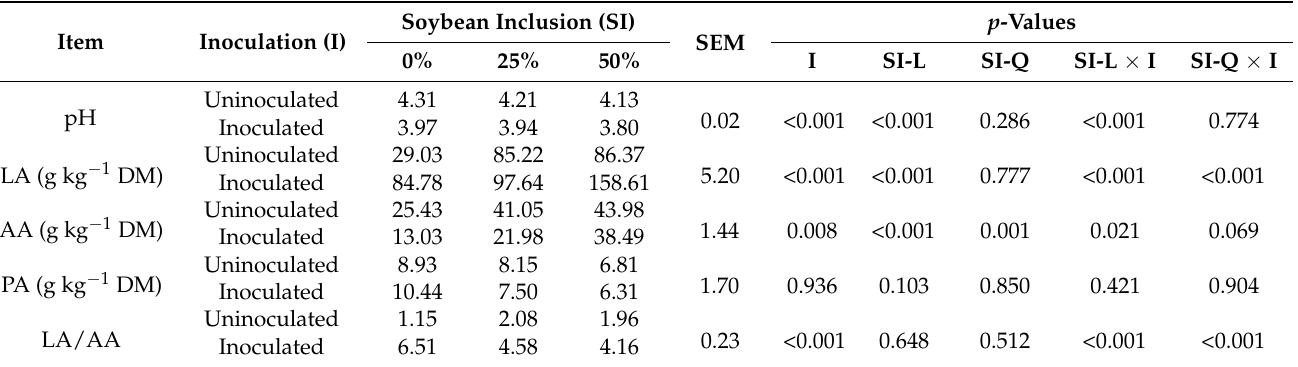
Figure 1. ( a , b ): Influence of soybean inclusion and L. plantarum A1 inoculation on dry matter and dry matter loss of sorghum silage. Table 2. Influence of soybean inclusion and L. plantarum A1 inoculation on fermentation profile of sorghum